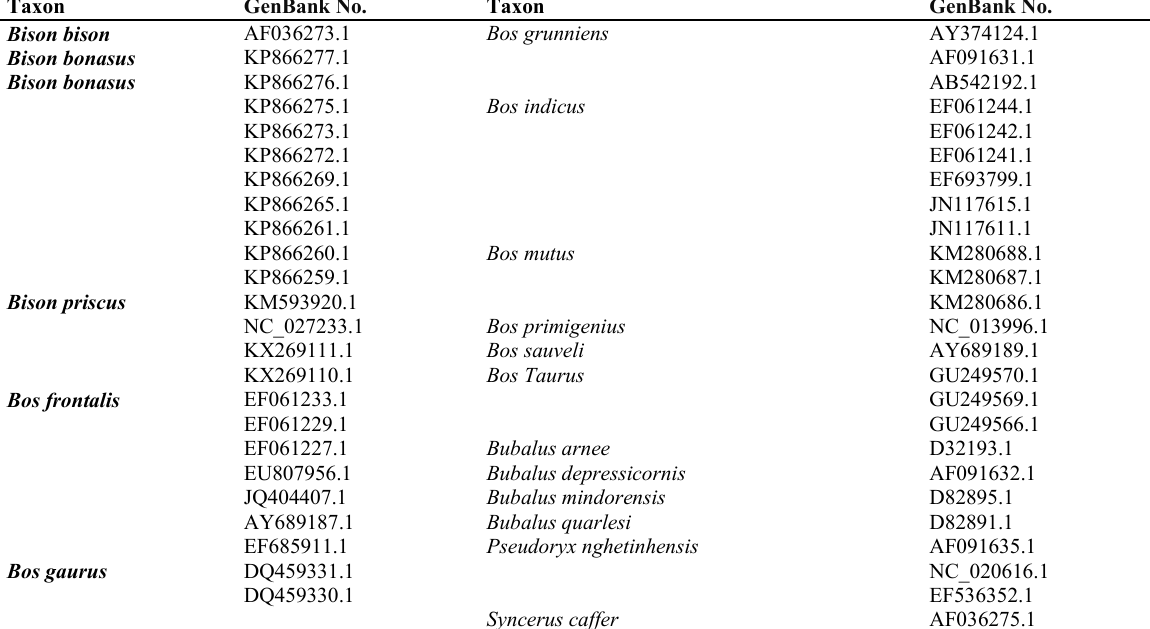
Table 2. The list of cytochrome b ( cytb ) gene samples (in alphabetical order) with GenBank accession number (n=49).